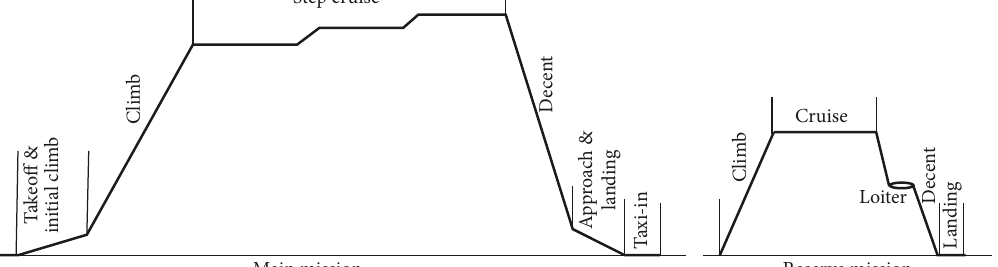
Figure 6: Nose gear collapse geometry.